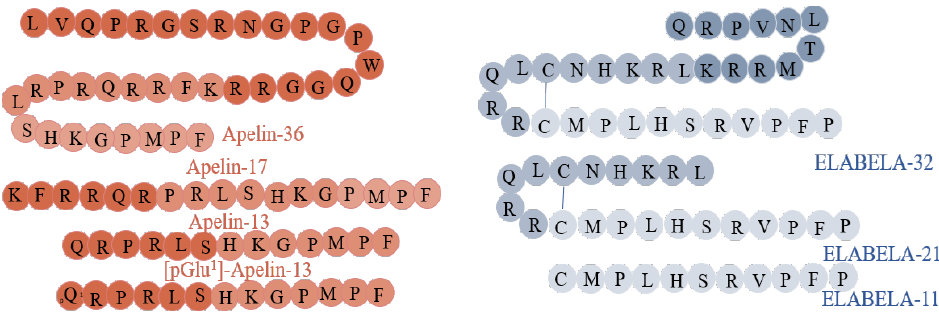
Figure 1. Structure and isoforms of apelin [9] and ELABELA